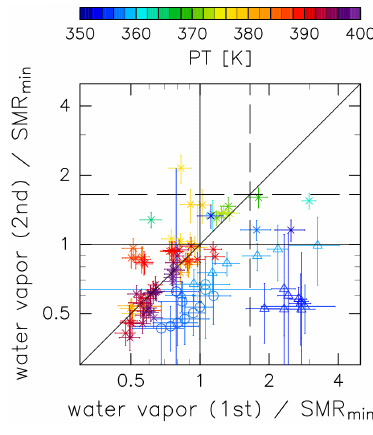
Fig. 9. Scatter plot of ratios of the water vapor mixing ratio at the first observation to SMR min estimated from the SMR history during advection (abscissa), versus ratios of the water vapor mixing ratio at the second observation to SMR min (ordinate), for all matches. Col- ors indicate the altitude (potential temperature). Symbols refer to the hygrometers (see the caption to Fig. 4). The dashed black lines indicate the approximate homogeneous freezing threshold